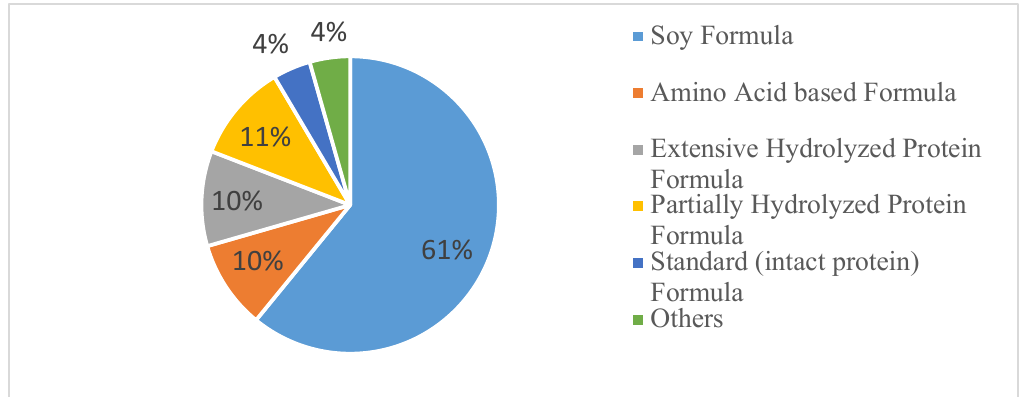
Figure 2. Nutritional products recommended by HCP for non-cow’s milk drinkers Table 2. Cross tabulation of recommendation level of soy formula